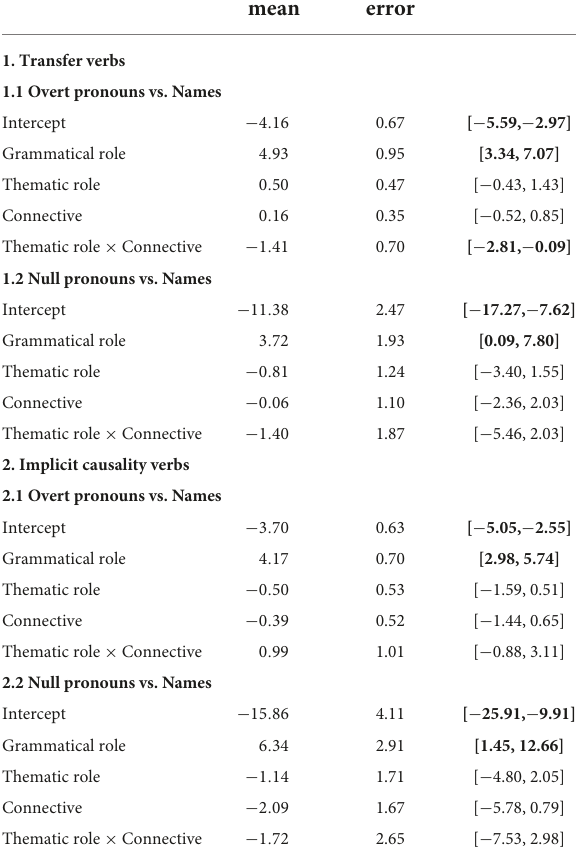
TABLE 2 Summary of the Bayesian mixed-effects categorical logistic regression model for the choice of referential form (95% credible intervals that do not contain zero, i.e., equivalent to significance in frequentist statistics, are